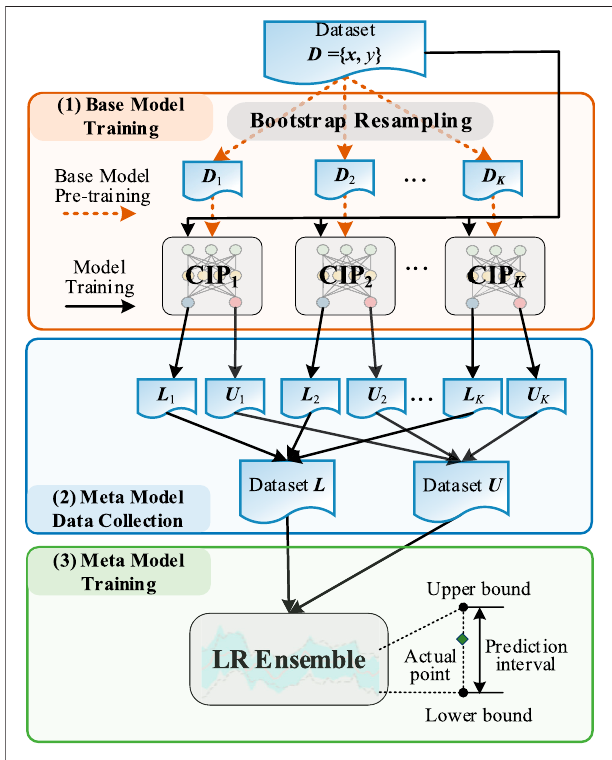
FIGURE 1 | Framework of the CIPE